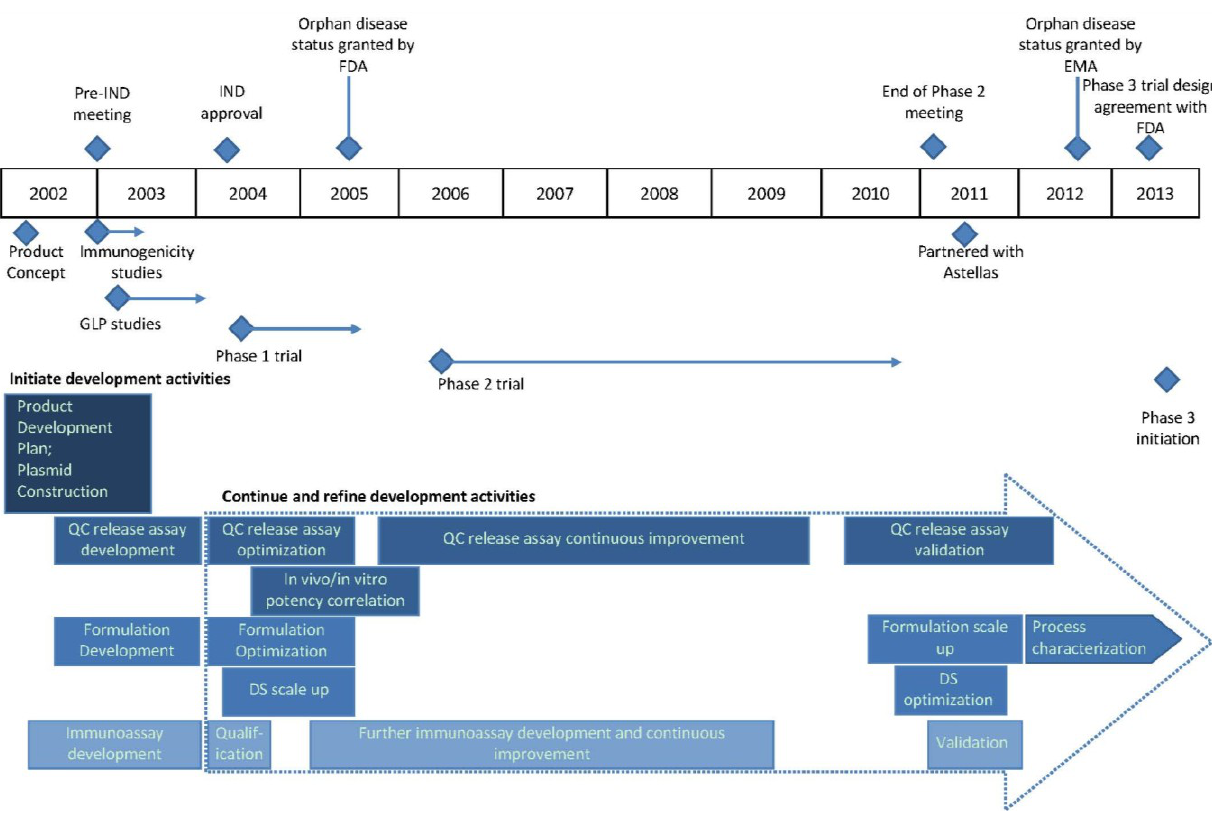
Figure 1. Clinical development timeline of ASP0113 (TransVax) from product concept in 2002 to initiation of a phase 3 trial in 2013. Initiation of various activities is shown in blue diamonds; regulatory activities are shown above the timeline and all others below the timeline. Horizontal blue lines and arrows depict the duration of the indicated